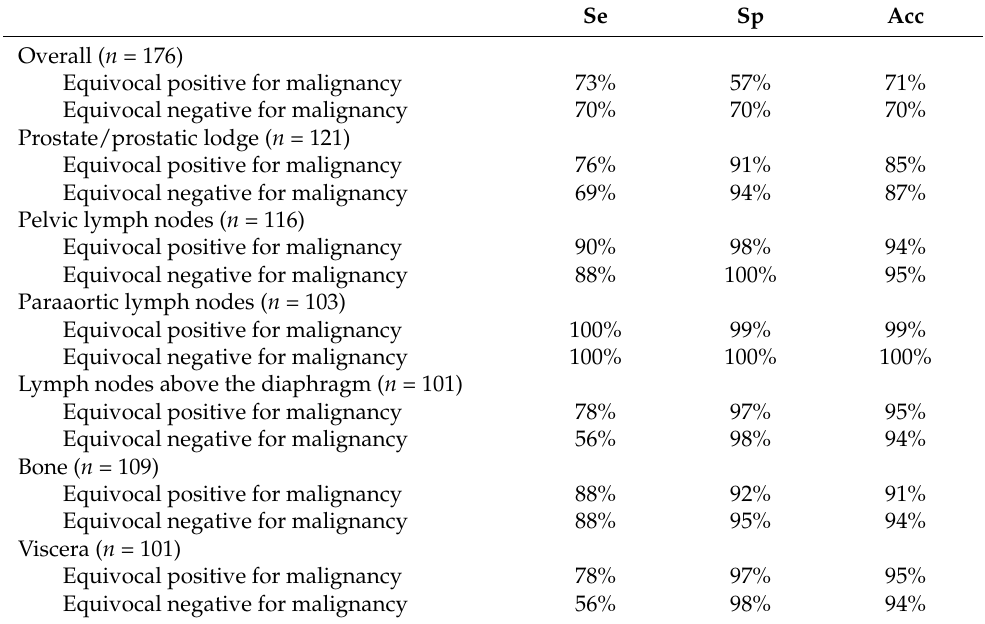
Table 3. [ 68 Ga]Ga-PSMA-11 PET/CT performances in prostate cancer patients investigated due to a biochemical recurrence (irrespective of total prostate-specific antigen serum values). Results with equivocal findings considered positive for malignancy and with equivocal results negative for malignancy are both presented. Patient-based and region-based analyses with the number of cases on which the standard of truth was